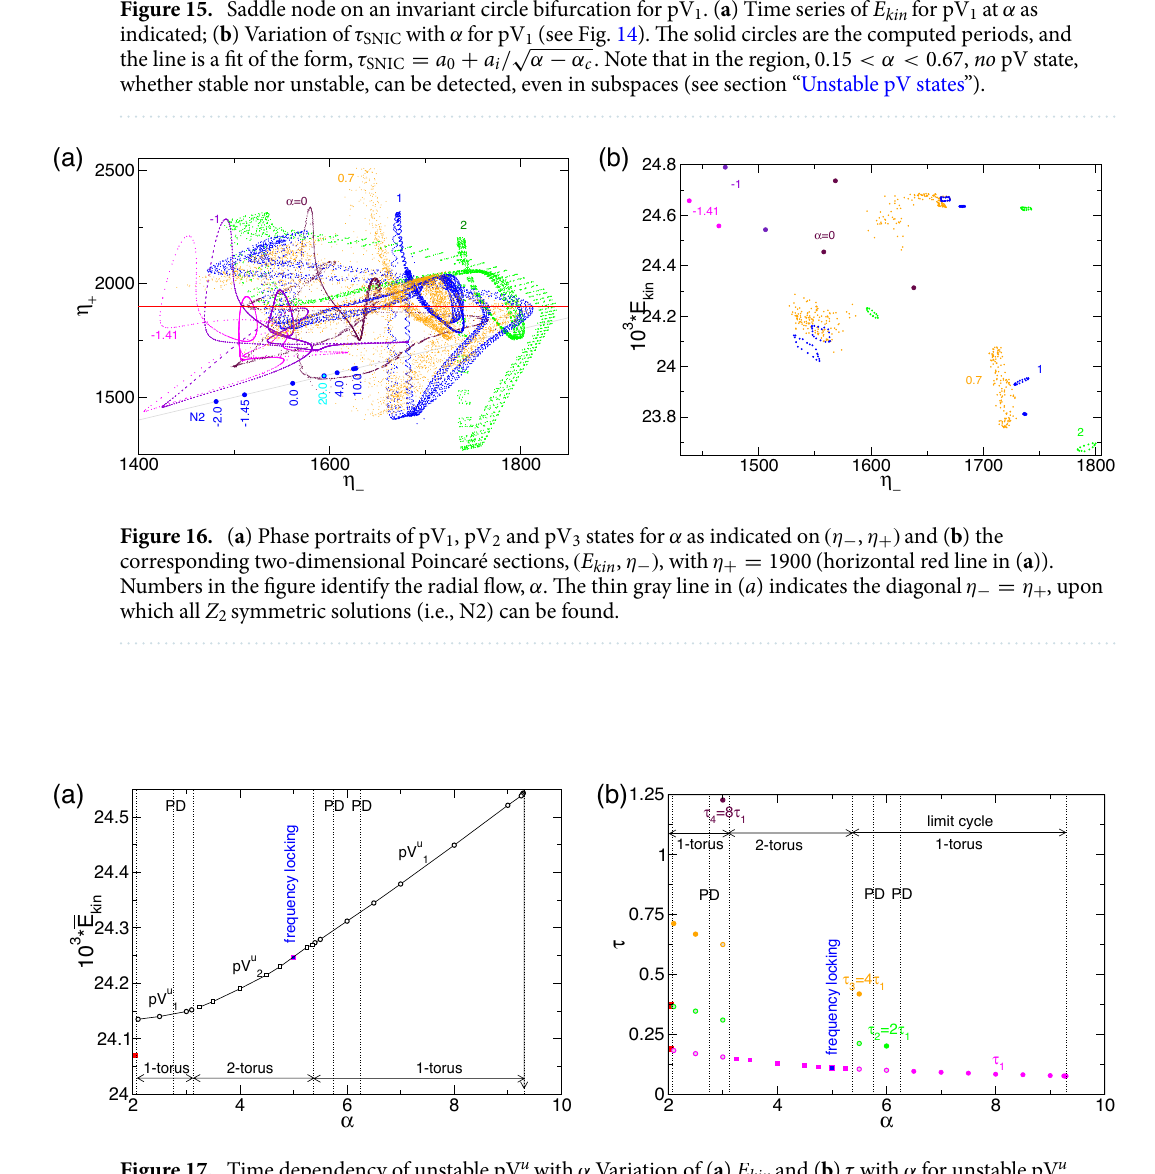
Figure 17. Time dependency of unstable pV u with α .Variation of ( a ) E kin and ( b ) τ with α for unstable pV u solutions. PD indicates period-doubling bifurcations. The vertical arrow in ( a ) illustrates a transition towards the stationary N2 state [outside the presented parameter range (smaller E kin ; see also Fig. 2). Colored symbols 1, 2, 3, 4 in ( b ) refer to the different period times τ i , i , respectively, which appear throughout the periodic ∈ { } doubling bifurcations (PD) as multiples of the basic period time τ i . Thus, these are all 1-torus, that are limit cycle solutions. The filled symbols show the actual period time τ p of the corresponding solution, while open symbols illustrate the still underlying time(s) at the bifurcating